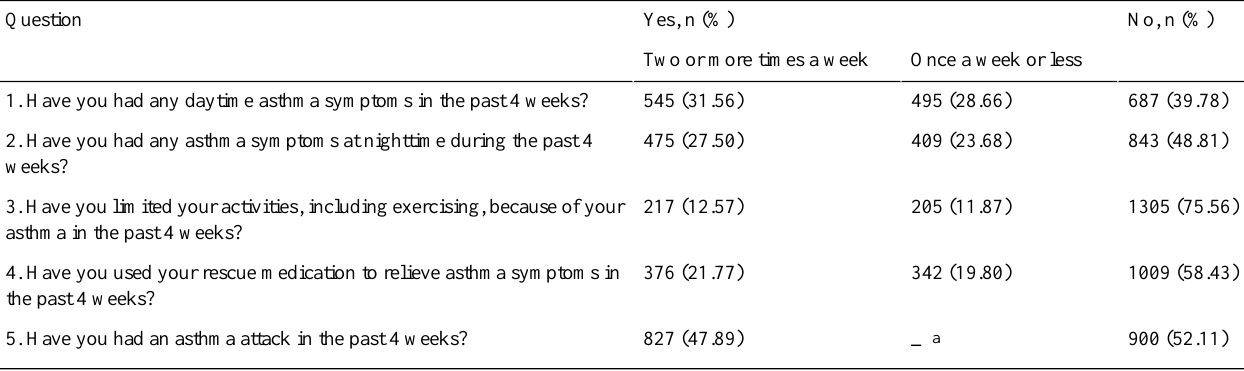
Table 4. Monthly Mobile Asthma Control Questionnaire